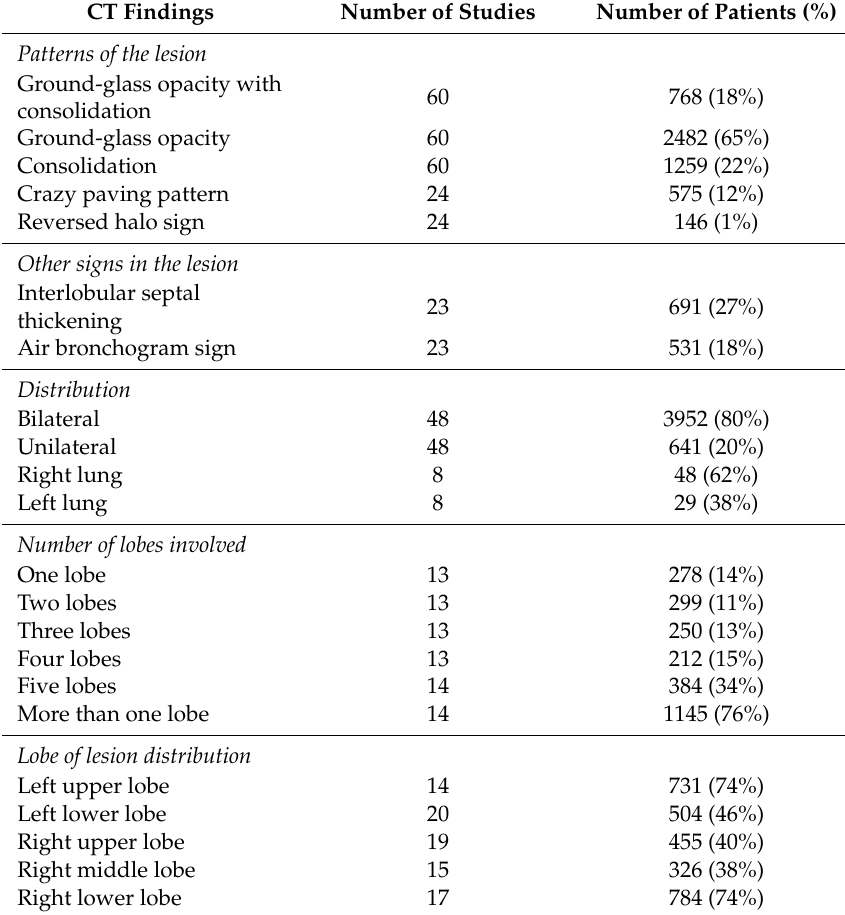
Table 4. CT imaging features of patients a ff ected by